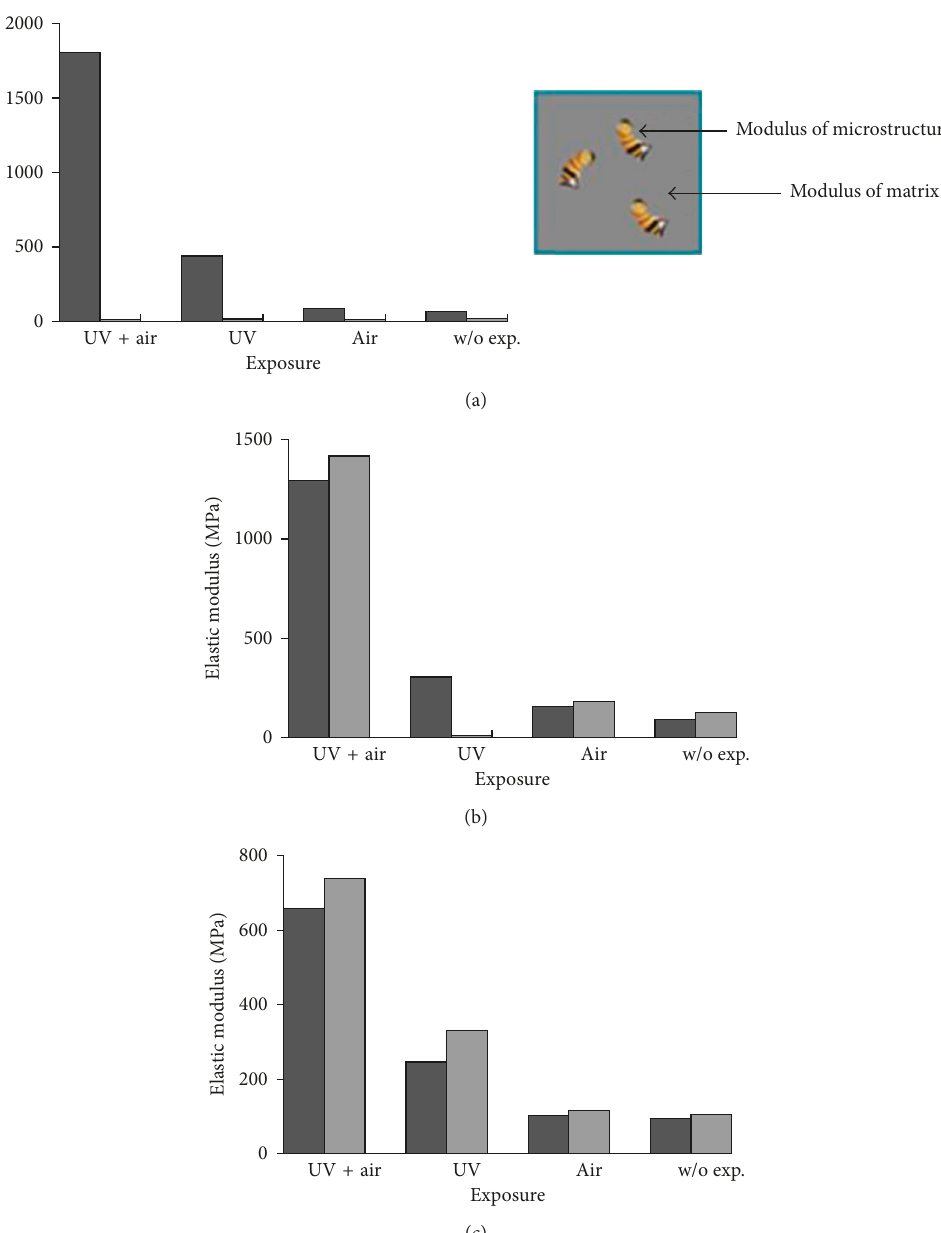
Figure 6: Variation in modulus measured using AFM at different levels of exposure for 3 different binders of different sources: (a) Bit-A, (b) Bit-B, and (c) Bit-C (from Das et al.